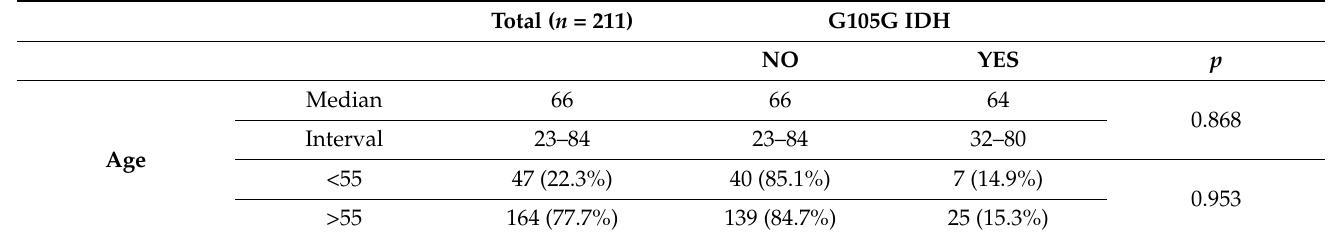
Table 1. Clinical characteristics according to IDH1 G105G SNP